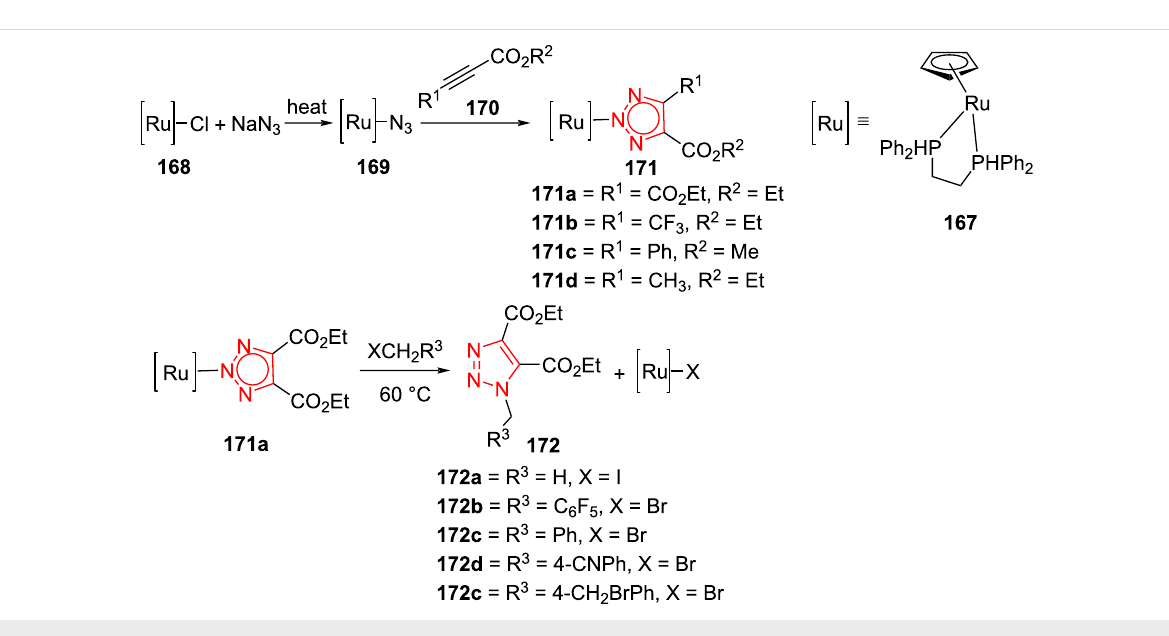
Scheme 45: Ru-catalyzed synthesis of fully decorated triazoles 172